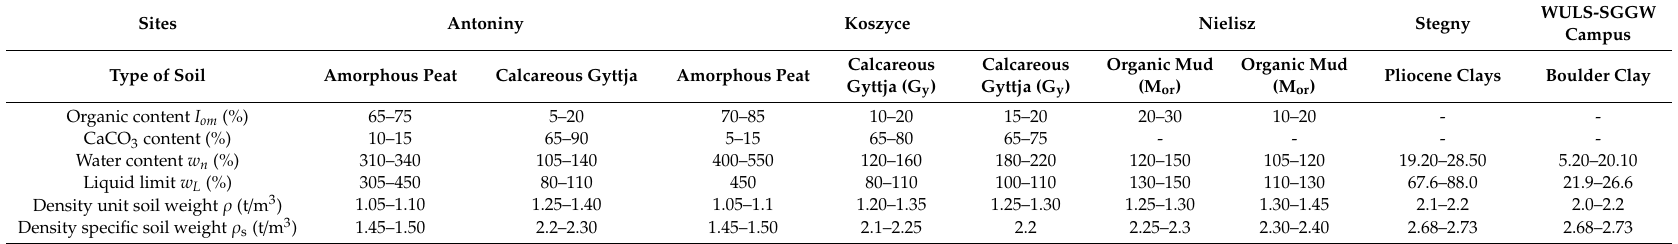
Table 1. Index properties of mineral and organic soils in the Antoniny, Koszyce, Nielisz, Stegny and Warsaw University of Life Sciences (WULS-SGGW) campus test sites.